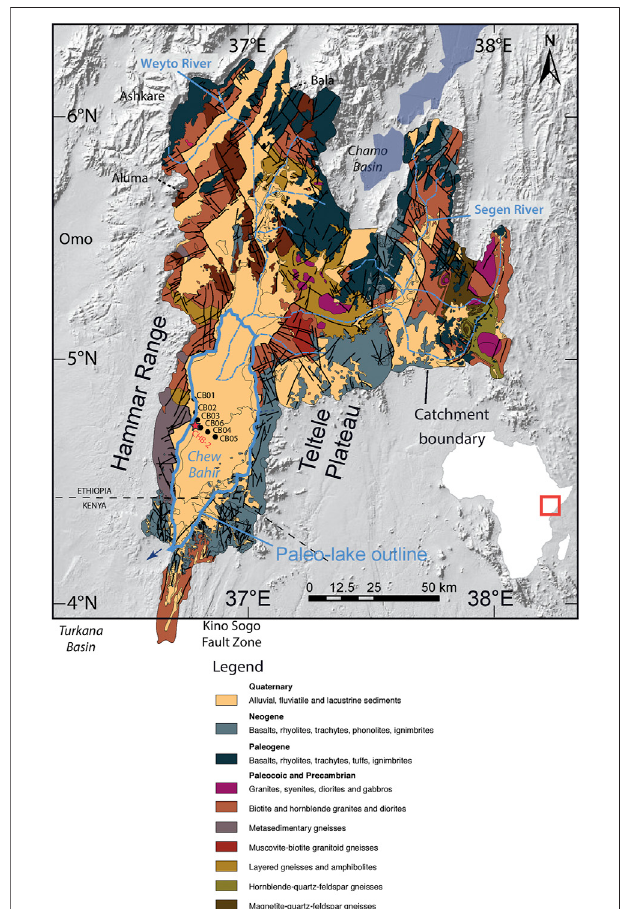
FIGURE1| Geologicmap oftheChewBahirBasin basedon OmoRiver Project Map (Davidson, 1983), Geology of the Sabarei Area (Key, 1987), Geology of the Yabello Area (Hailemeskel and Fekadu, 2004), and Geology of the Agere Maryam Area (Hassen et al., 1997). The red star marks the location of CHB14-2 coring